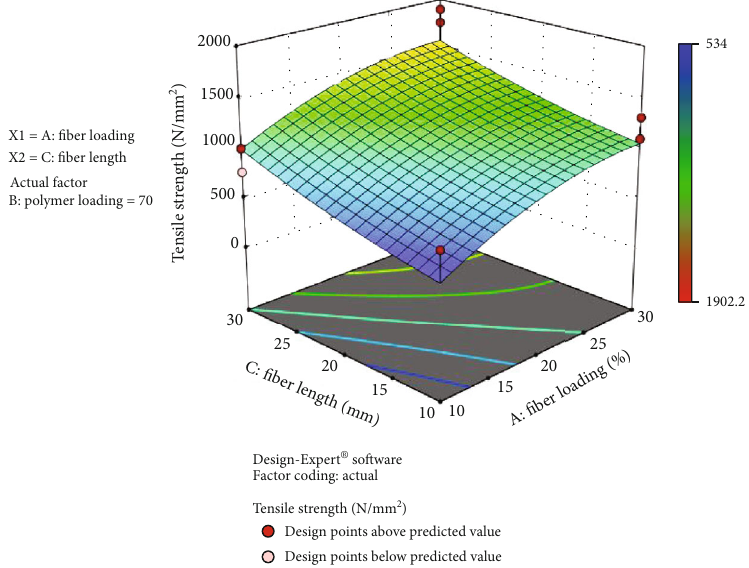
Figure 6: E ff ect of fi ber weight proportion as a function of fi ber length on tensile strength.